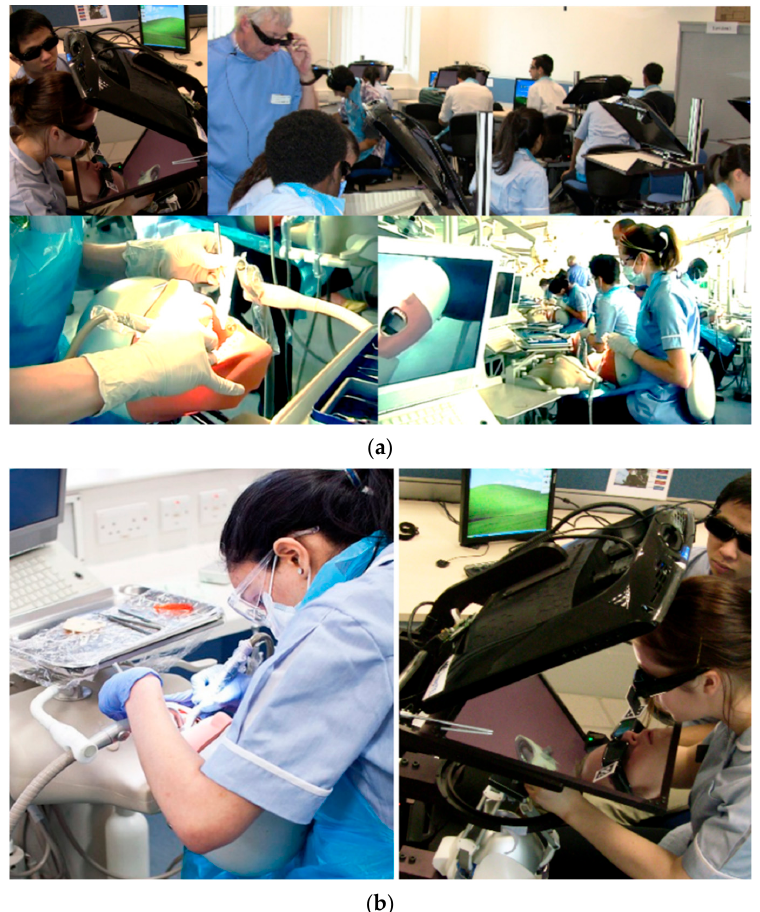
Figure 1. ( a ) The phantom and the haptics Clinical Skills Laboratories. The top figure shows the teacher glancing over the students working on an example haptic tooth task. The bottom figure shows students performing the removal of artificial caries on a plastic tooth. ( b ) Students training on the phantom head simulator ( left ) and VR haptic simulator ( right